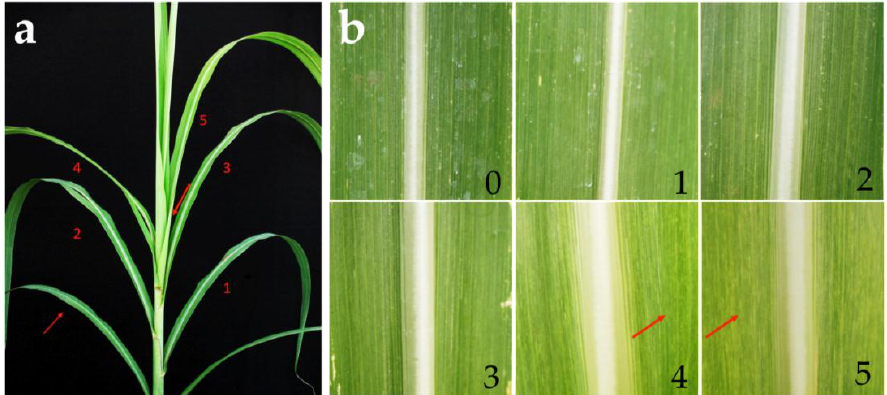
Figure 2. Sugarcane plant used in the inoculation experiment. ( a ) Plant was inoculated with symptomatic plant sap at the site of inoculation, indicated by number zero (0). ( b ) Representative sugarcane leaves from inoculated plant. Numbers indicate leaves upward from the inoculation site (1-5). Arrows indicate mosaic symptoms.